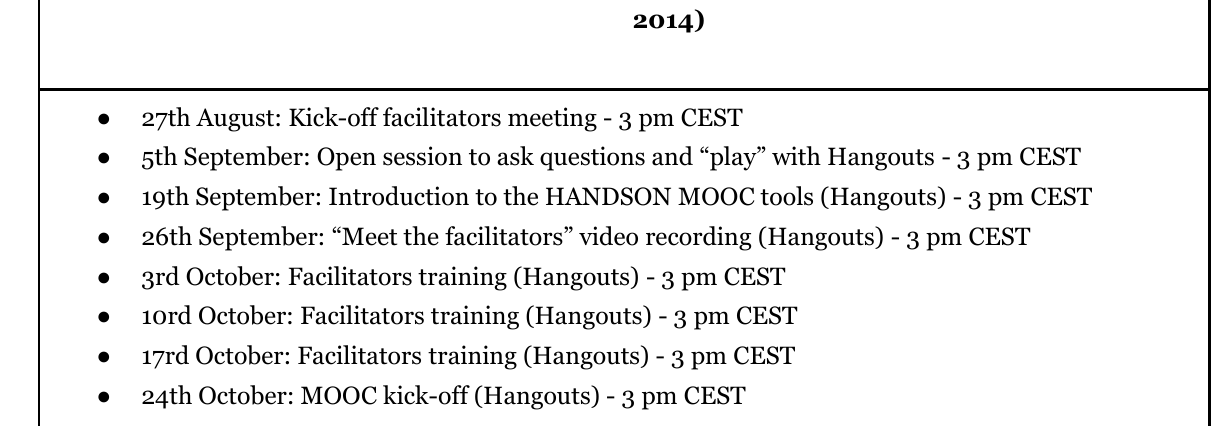
Table Pre-Course Activities - Facilitators